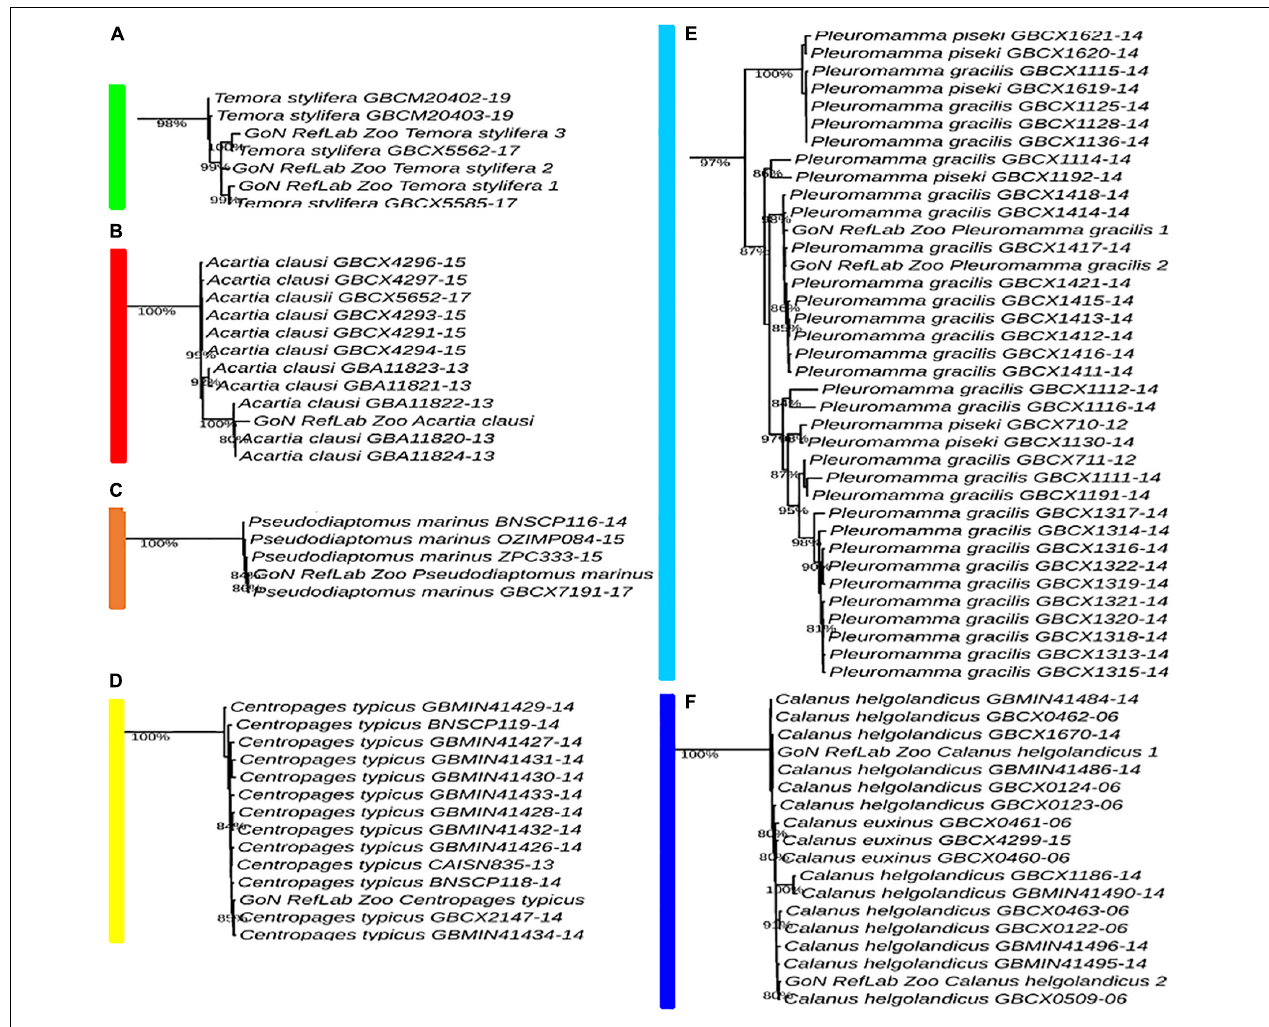
FIGURE 5 | Molecular identification based on ML tree. Portions from the full tree are illustrated: (A) Temora stylifera; (B) Acartia clausi ; (C) Pseudodiaptomus marinus ; (D) Centropages typicus ; (E) Pleuromamma gracilis ; (F) Calanus helgolandicus. Full tree available in Supplementary Figure 1 .